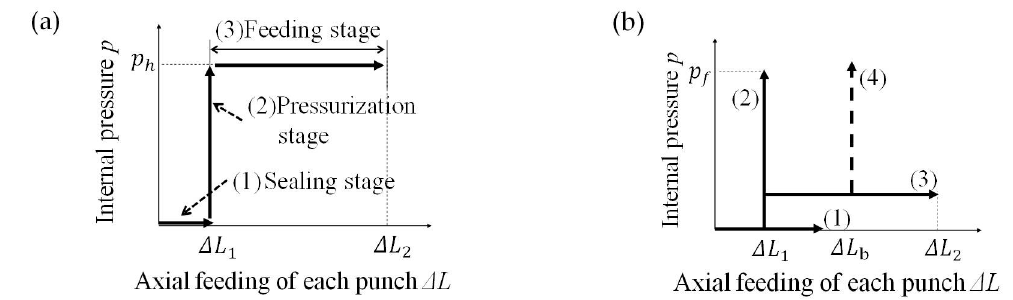
Figure 6. Loading path used in T-shape MTHF: ( a ) basic loading path; and ( b ) loading path for determining the process window.